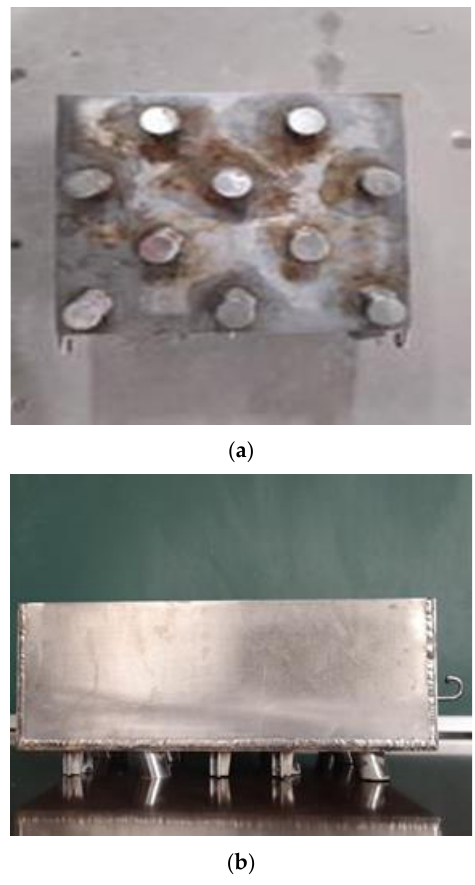
Figure 6. Model of gravity anchor. ( a ) Top view ; ( b ) Front view.